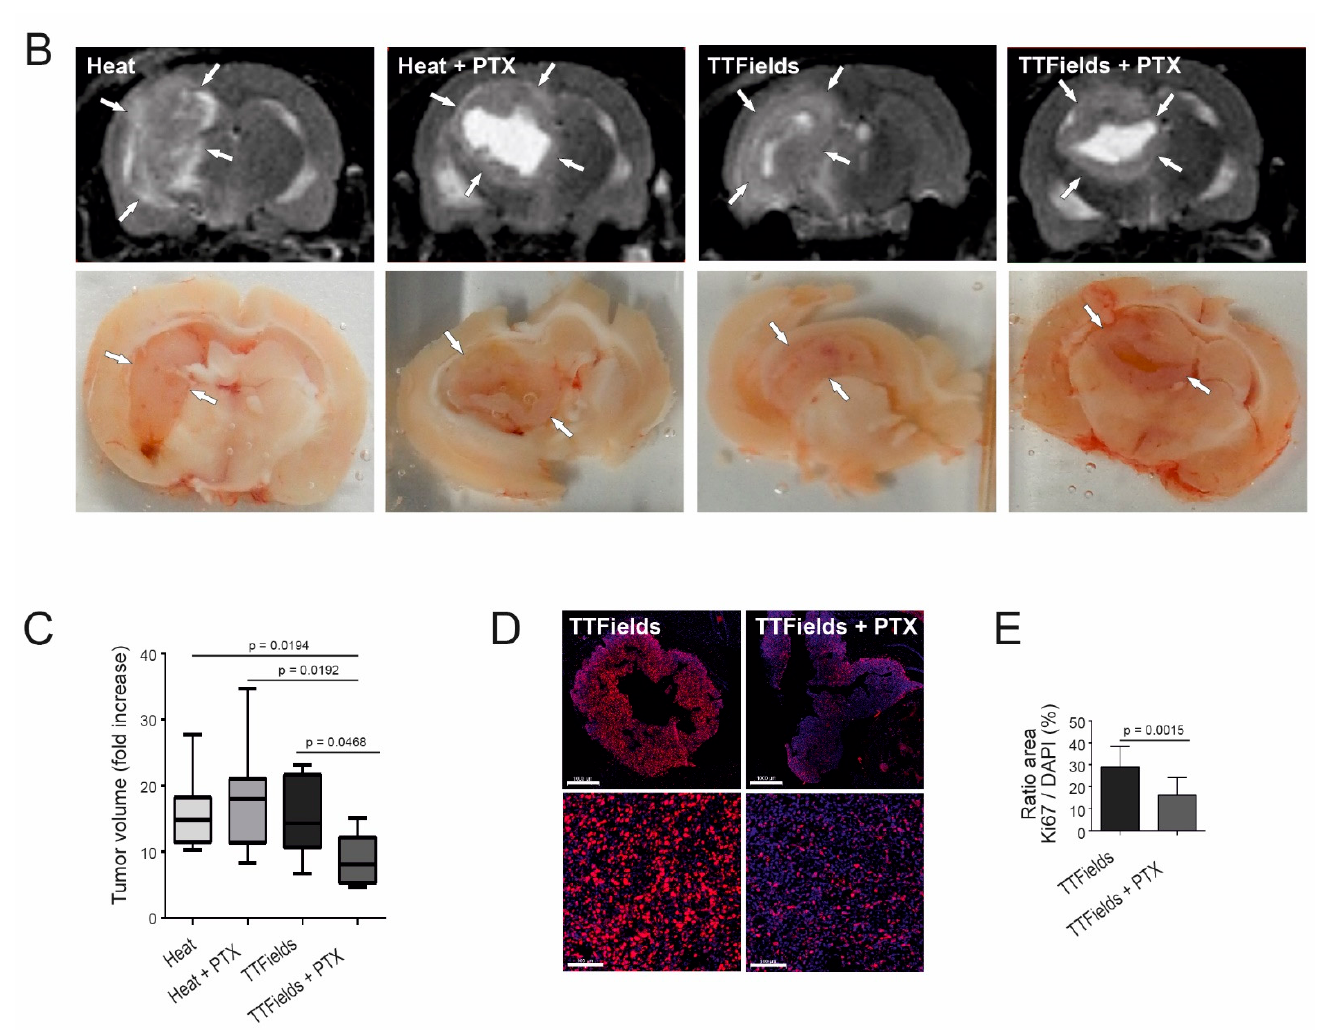
Figure 6. Combined TTFields and PTX treatment of rats. ( A ) Schematic representation of the time course. Rats (seven to eight animals per group) were injected orthotopically with GBM F98 cells. PTX (15 mg/kg) or vehicle were injected intraperitoneally on day 3 of TTFields at 100 kHz. ( B ) MRI scans (upper) and postmortem tissue sections (lower) at day 15 after tumor injection. Arrows indicate the tumor boundaries. ( C ) Quantification of the fold tumor volume increase in the different treatment groups. ( D ) Ki67 (red) and DAPI (blue) staining of combined TTFields-PTX treatment in the GBM tumor 3 days post-intraperitoneally 25 mg/kg PTX administration (3–4 rats per group). Scale bars = 1000 (upper) and 100 µ m (lower), respectively. ( E ) Quantification of the Ki67/DAPI ratio showing decreased cell proliferation in the GBM tumor with the combined